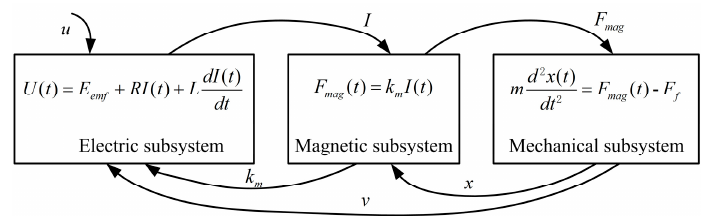
Figure 4. Coupled mathematical model of the ELA.